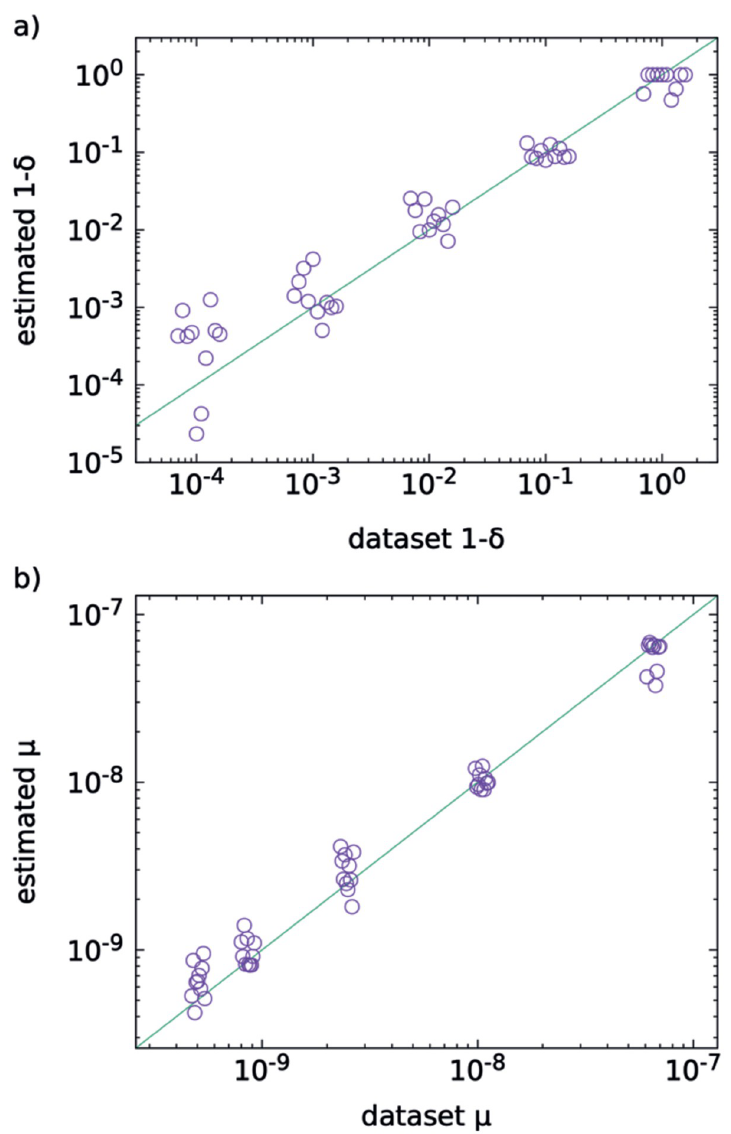
Fig 2. True vs. estimated death-to-birth ratios and mutation rates. In subplot A), the growth rate 1 − δ (in units of the birth rate) is shown for better visualization. In both A) and B), 10 synthetic datasets were generated for each true value, with an independent cell lineage tree and associated mutations for each replicate. For each replicate 10 4 trees with 10 4 leaves were used for fitting (see the Materials and methods for details on calculating the likelihood). Points are slightly dispersed horizontally for clarity. Datasets are the same for A) and B). Horizontal ordering of the data points is the same for both subplots, e.g., the rightmost point in each group of points corresponds to dataset no. 10 in both